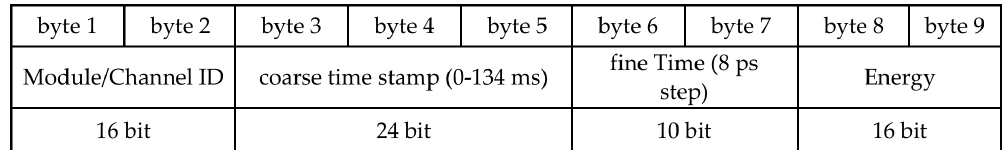
Figure 16. Block scheme of the VX2740 digitizer operational features.